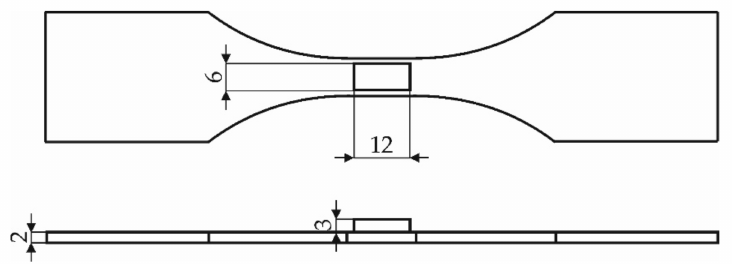
Figure 3. Geometry of the base specimen with brazed-on local reinforcement, with dimensions in mm.